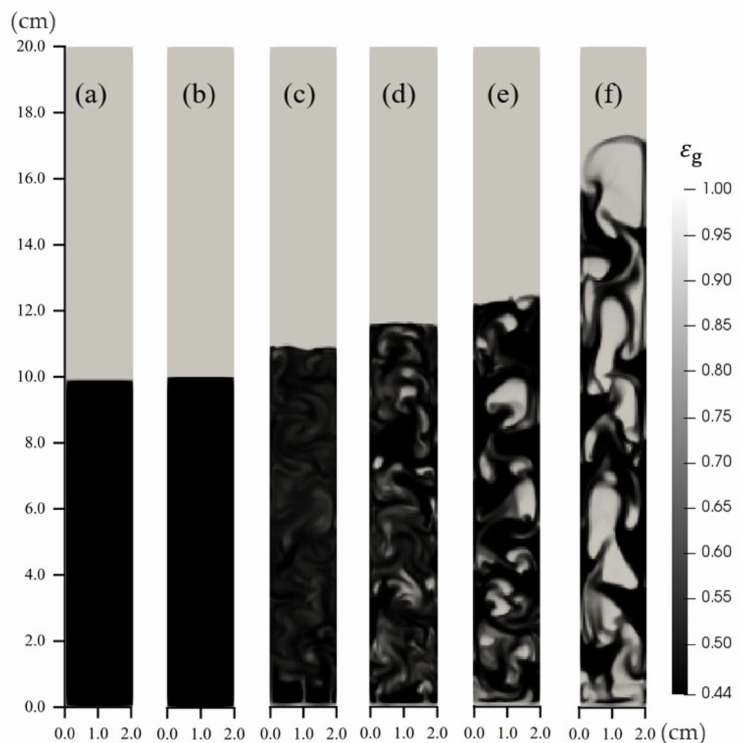
Figure 3. Gas–solid flows with different CO 2 inlet velocities, v CO ( c ) 0.9 cm/s, ( d ) 1.5 cm/s, ( e ) 3.0 cm/s, ( f ) 11.0